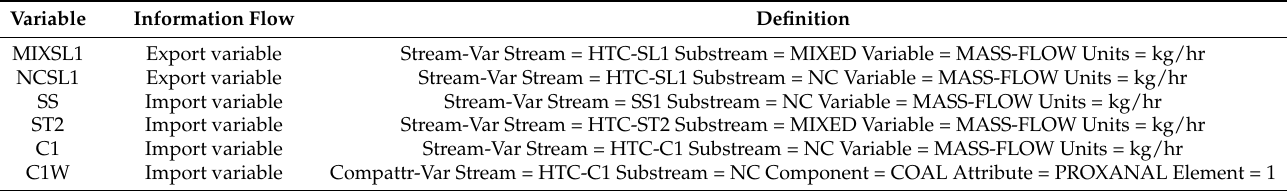
Table A6. Variables used in calculator block MBALANCE .